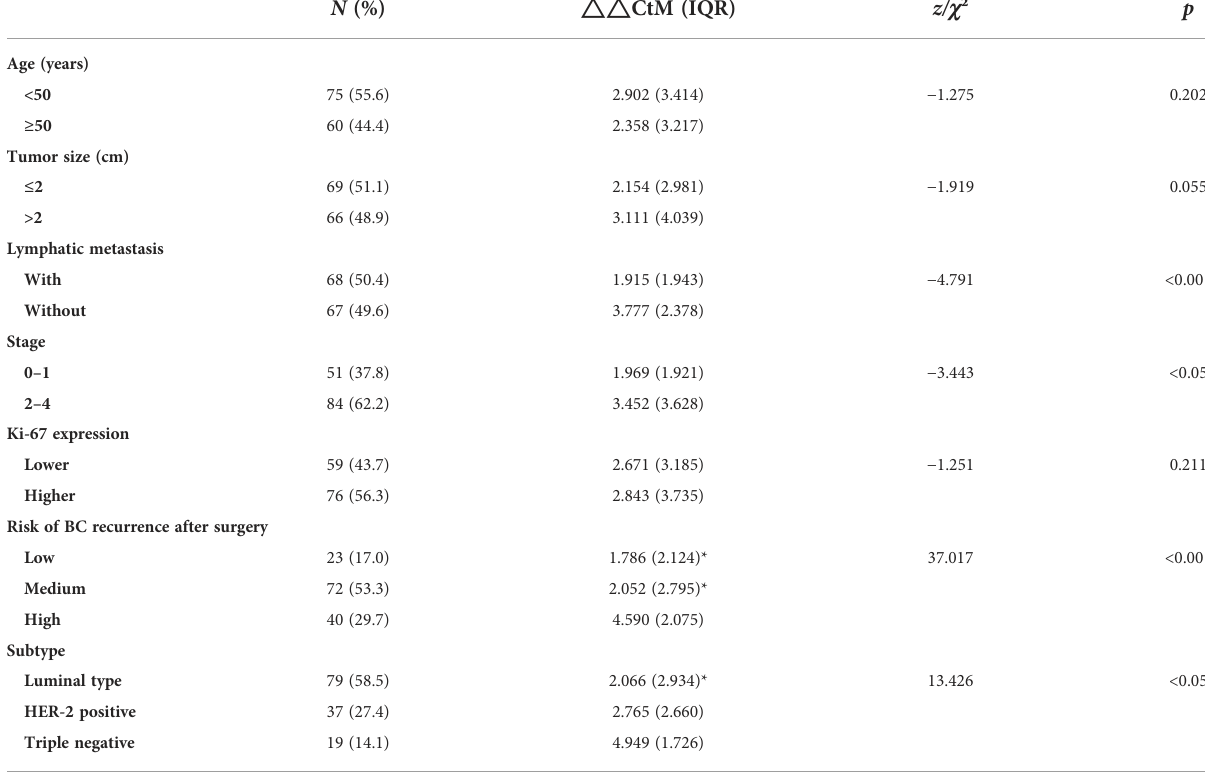
TABLE 1 The difference in hsa_circ_0058514 expression level associated with the clinical characteristics of BC patients.